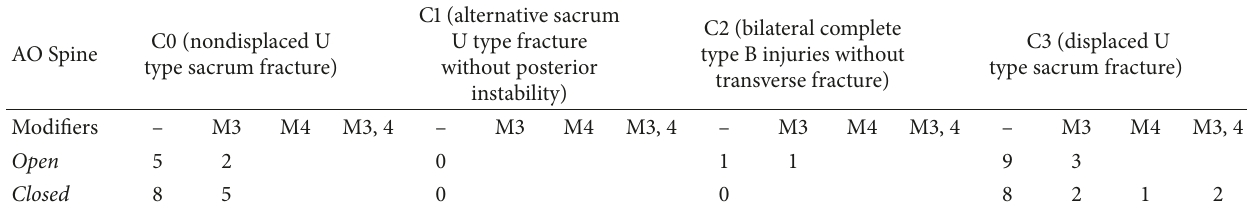
Table 2: Fracture pattern classification. All fracture patterns were AO sacrum classification type C.